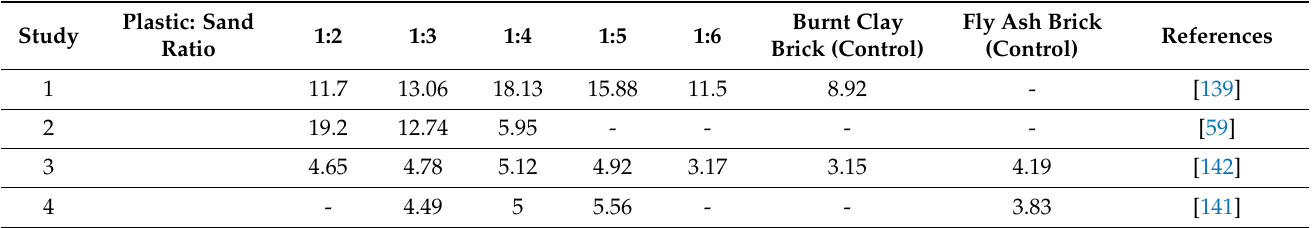
Table 1. Comparison of compressive strength (Mpa) of various experimental studies that manufac- tured plastic sand bricks.